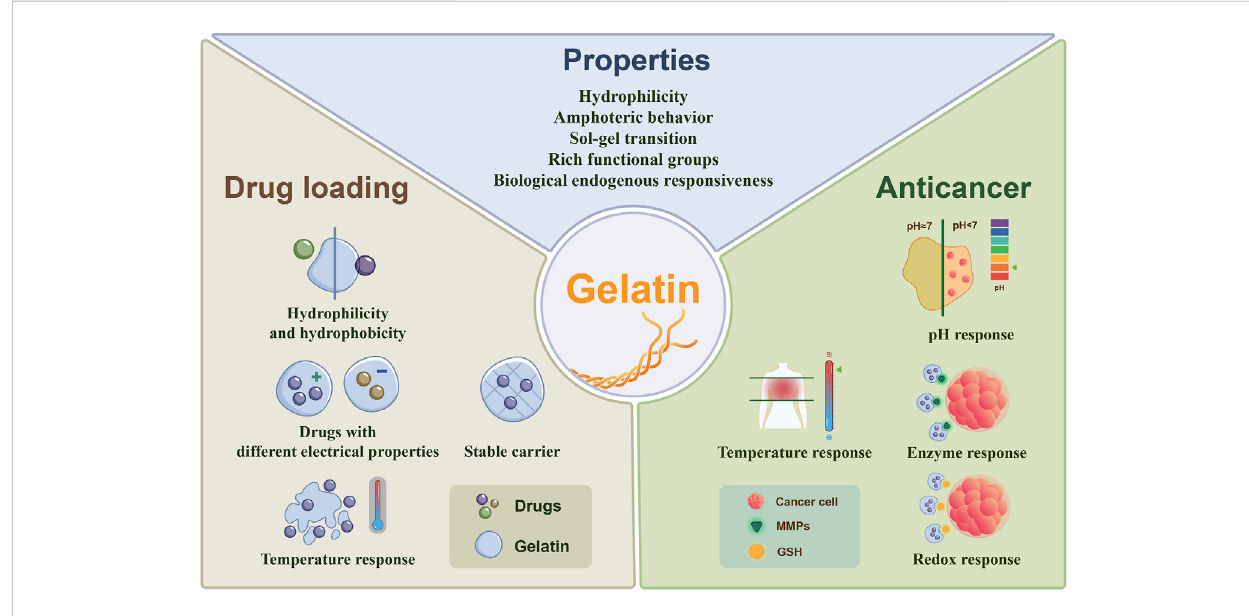
FIGURE 1 Properties of gelatin used in anticancer